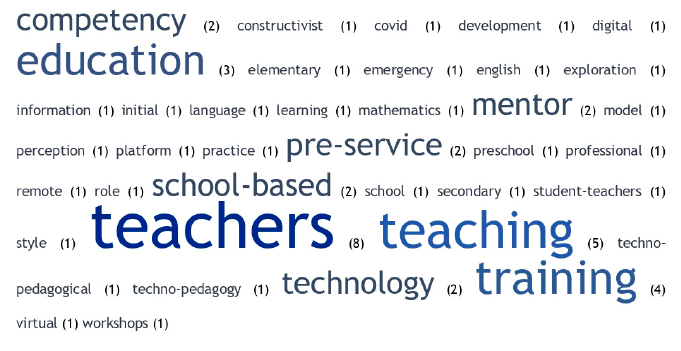
Figure 7. Word cloud among senior teachers.